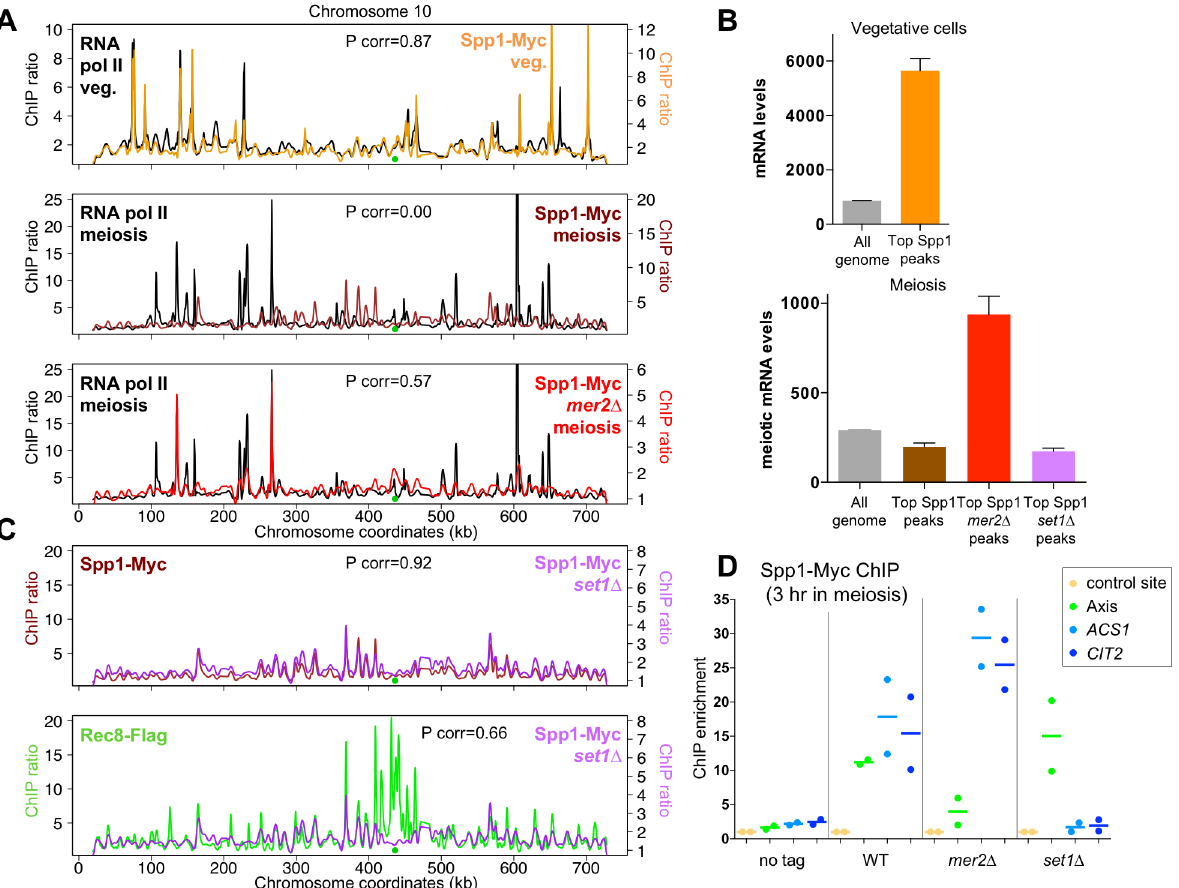
Fig 2. Spp1 binds distinct Set1- and Mer2-dependent sites in meiotic cells. (A) Comparison of Spp1 binding profile with that of RNA polymerase II, in vegetative cells, or in meiosis (t = 3 hr), in wild-type or mer2 Δ mutant. Spp1-Myc and RNA pol II binding data are from [18]. Spp1-Myc mer2 Δ : VBD1220. ChIPchip (Chromatin immunoprecipitation on chip) profiles are shown for chromosome 10. Centromeres are indicated by green dots, and ratios are plotted after smoothing with a 1 kb window. (B) Mean mRNA levels at the 100 strongest Spp1 peaks or in the whole genome. Spp1 peaks were determined from the experiments shown in A (see Methods). mRNA levels are from published data in SK1 diploid vegetative cells [57] (upper panel) or SK1 meiotic cells at t = 4 hr [58] (lower panel). Error bars: S.E.M. (C) Spp1 and Rec8 binding profile in SET1 or set1 Δ cells in meiosis (t = 3 hr). Spp1-Myc set1 Δ :VBD1209. SET1 Spp1-Myc and Rec8 binding data are from [18]. ChIPchip profiles are shown for chromosome 10. Centromere is indicated as a green dot, and ratios are plotted after smoothing with a 1 kb window. (D) qPCR analysis of Spp1 binding to an